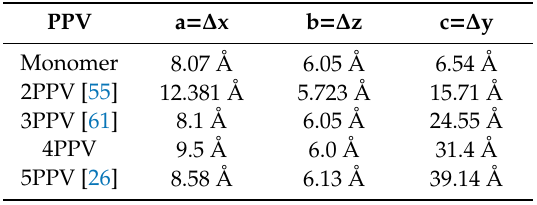
Table 4. Initial simulation cell for oligomer crystallizations.